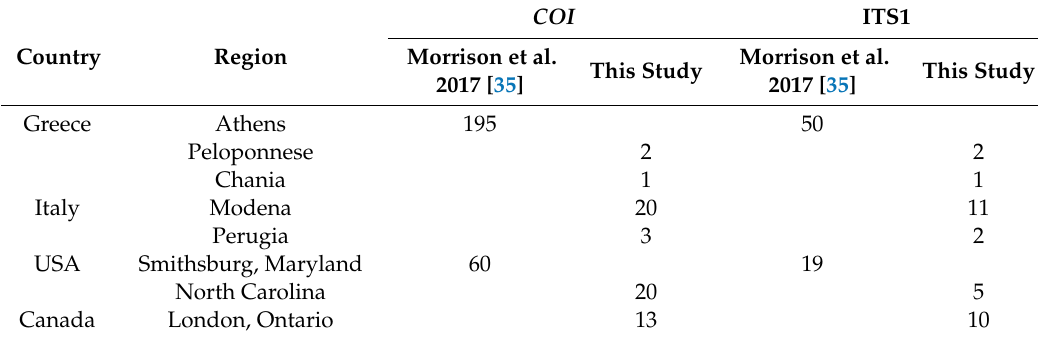
Table 1. Populations of H. halys used in this study and total number of specimens from each population analyzed for the molecular markers Cytochrome Oxidase I ( COI ) and Internal Transcribed Spacer 1 (ITS1). COI ITS1 Country Region Morrison et al. Morrison et al. This Study This Study 2017 [35] 2017 [35] Athens 195 50 2